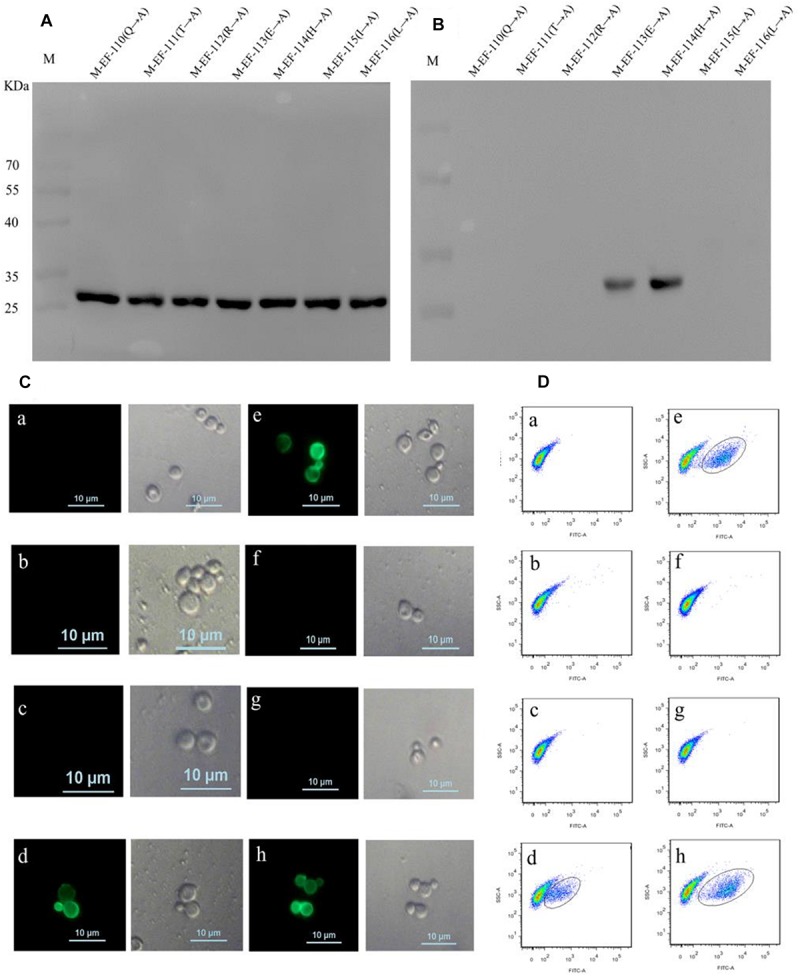
Identification of the crucial residue of the epitope to McAb BD6. (A) Western blotting analysis of seven mutagenesis epitope peptides expressed in E. coli BL21 (DE3) using anti-GST McAb as primary antibody. (B) Western blotting analysis of seven mutagenesis epitope peptides by western blotting to confirmed central sequence of epitope, using McAb BD6 as primary antibody. (C,D) Indirect immunofluorescence assay (C) and flow cytometry (D) analysis yeast cells displayed seven mutagenesis EF-Tu proteins. (a) Yeast cell displaying P-EF-Tu-(Q110-A) protein; (b) yeast cell displaying P-EF-Tu-(T111-A) protein; (c) yeast cell displaying P-EF-Tu-(R112-A) protein; (d) yeast cell displaying P-EF-Tu-(E113-A) protein; (e) yeast cell displaying P-EF-Tu-(H114-A) protein; (f) yeast cell displaying P-EF-Tu-(I115-A) protein; (g) yeast cell displaying P-EF-Tu-(L116-A) protein; and (h) yeast cell displaying B. melitensis EF-Tu protein as positive control. BD6 as primary antibody and fluorescein isothiocyanate (FITC)-conjugated goat anti-mouse IgG [H + L] as secondary antibody.